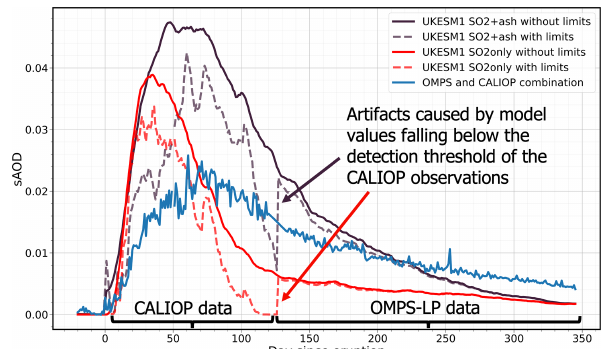
Figure 7. Daily perturbation of sAOD at 532nm averaged over 30–90 ◦ N. Daily OMPS-LP and CALIOP combined dataset sAOD (blue), UKESM1 SO2only with observational limits applied (red) and without limits applied (dashed red ), and UKESM1 SO2 + ash with observational limits applied (dark purple) and without lim- its applied (dashed dark purple). We remove the long-term back- ground sAOD derived from OMPS-LP and CALIOP for the years 2013–2018 from those for 2019 to provide a stratospheric pertur- bation for the observations. Similarly, we remove the impacts of background stratospheric aerosol from the model simulations by subtracting the sAOD from the CNTL simulation from those for SO2only and SO2 + ash.